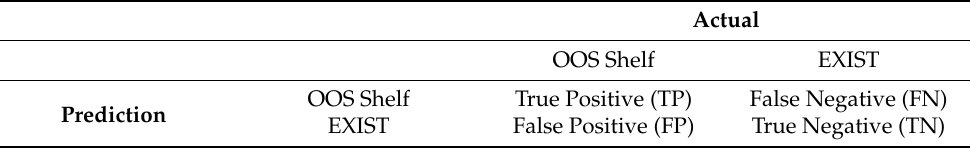
Table 2. Confusion